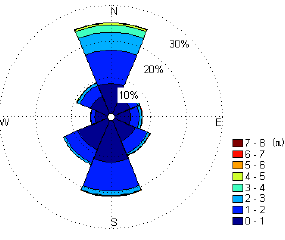
Figure 4. The rose plot of significant wave heights from 1990 to 2011 at location S1.